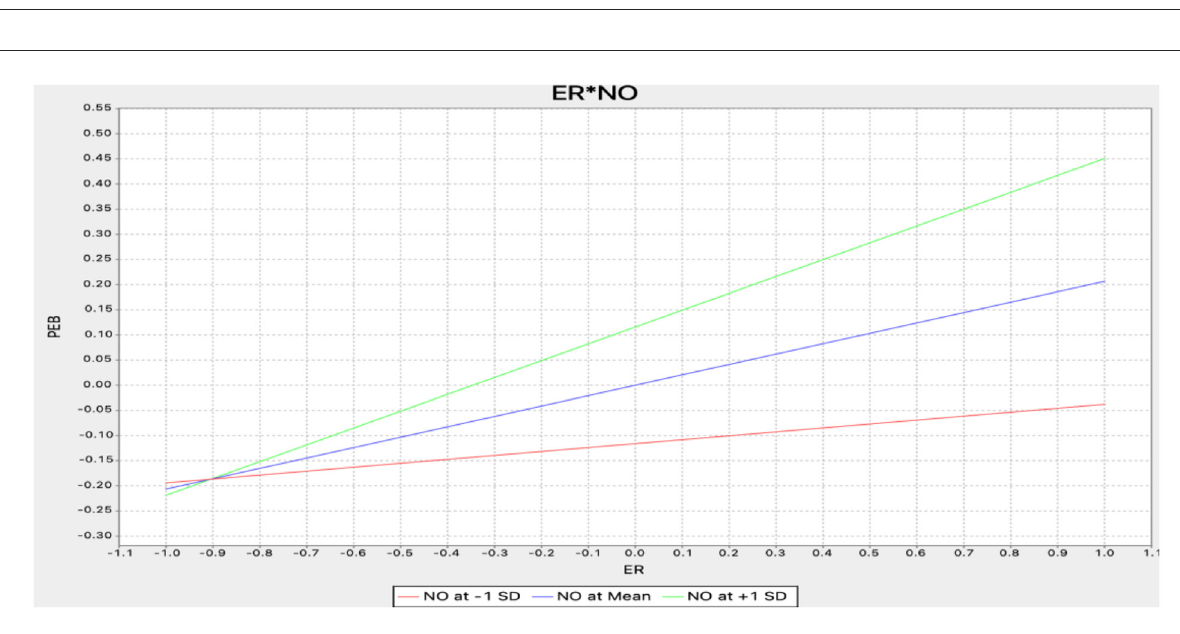
environmental empathy, 16.5% of environmental responsibility, 12.1% of NAMF, 39.6% of perceived threat, and 4.4% of perceived vulnerability must